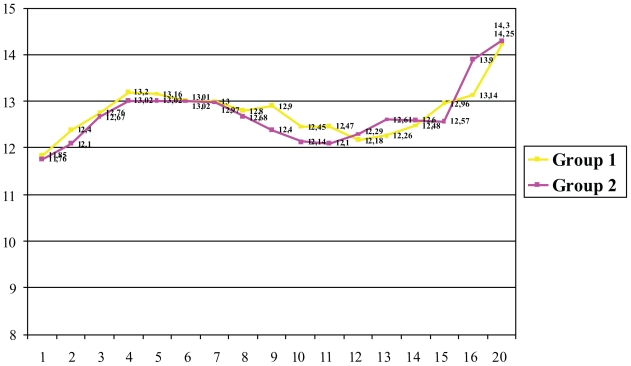
Changes in the Hb over the course of the study.